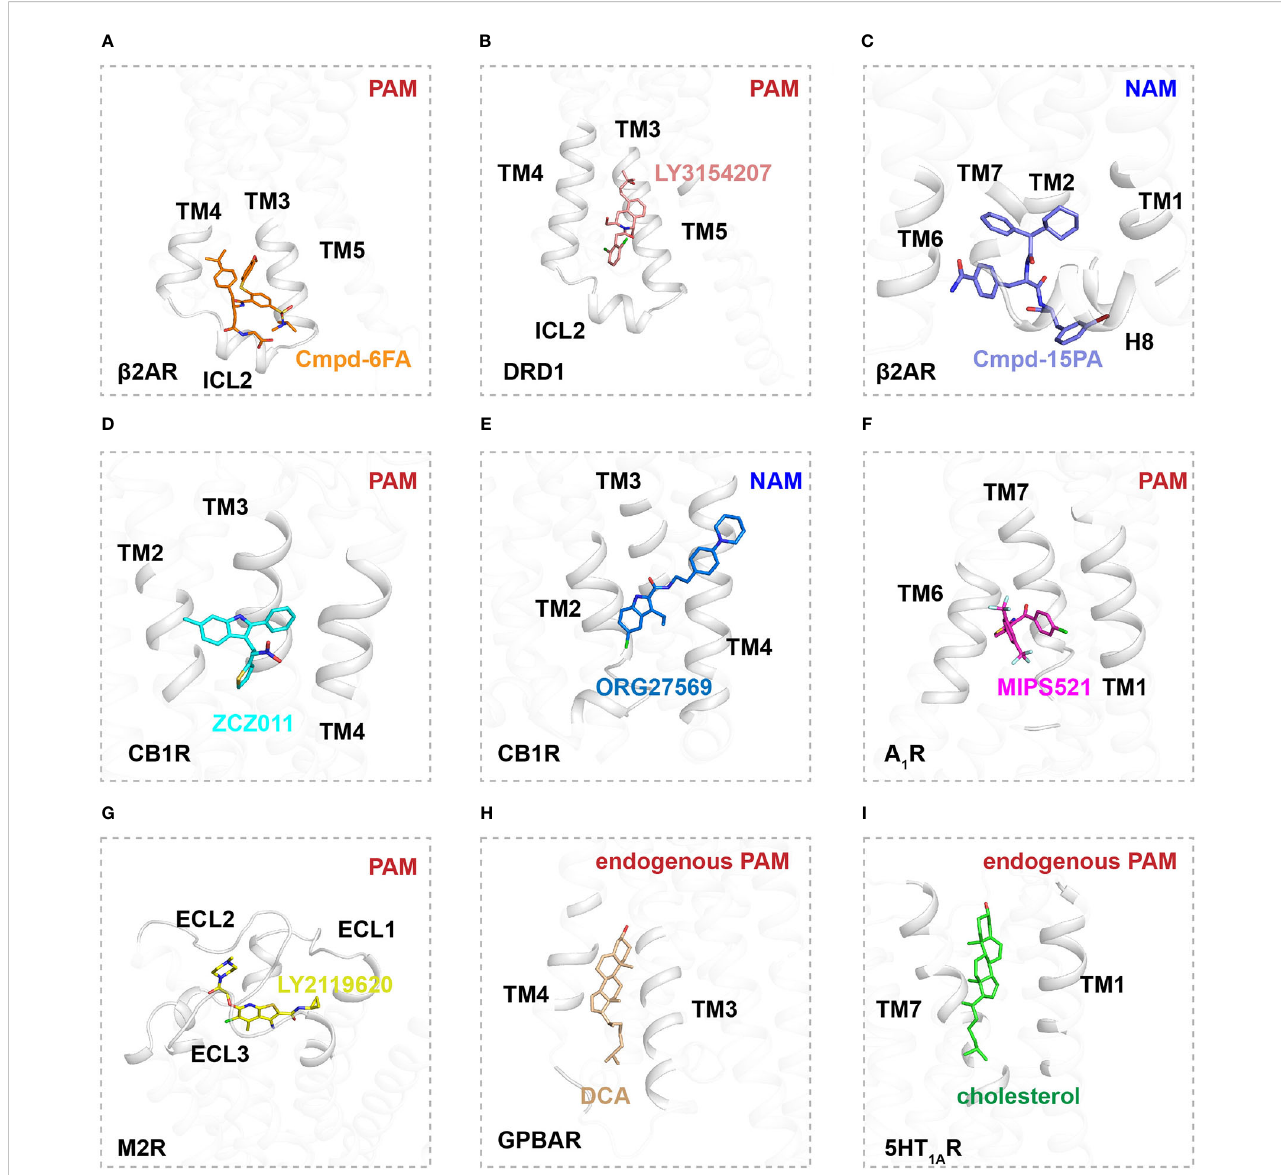
FIGURE 2 Binding sites of allosteric modulators in Class A GPCRs. (A) Interactions of Cmpd-6FA (orange, sticks) with TM2, TM3, TM4, and ICL2 of b 2AR (gray, cartoon) (PDB ID: 6N48). (B) Interactions of LY3154207 (pink, sticks) with TM2, TM3, TM4, and ICL2 of DRD1 (gray, cartoon) (PDB ID: 7CKZ). (C) Interactions of Cmpd-15PA (purple, sticks) with TM1, TM2, TM6, TM7, H8 and ICL1 of b 2AR (gray, cartoon) (PDB ID: 5X7D). (D) Interactions of ZCZ011 (blue, sticks) with TM2, TM3 and TM4 of CB1R (gray, cartoon) (PDB ID: 7WV9). (E) Interactions of ORG27569 (deep blue, sticks) with TM2, TM3 and TM4 of CB1R (gray, cartoon) (PDB ID: 6KQI). (F) Interactions of MIPS521 (magentas, sticks) with TM6 and TM7 of A1R (gray, cartoon) (PDB ID: 7LD3). (G) Interactions of LY2116920 (yellow, sticks) with extracellular region of M2R (gray, cartoon) (PDB ID: 4MQT). (H) Interactions of DCA (wheat, sticks) with extracellular region of GPBAR (gray, cartoon) (PDB ID: 7CFM). (I) Interactions of cholesterol (green, sticks) with TM1 and TM7 of 5-HT1A (gray, cartoon) (PDB ID: